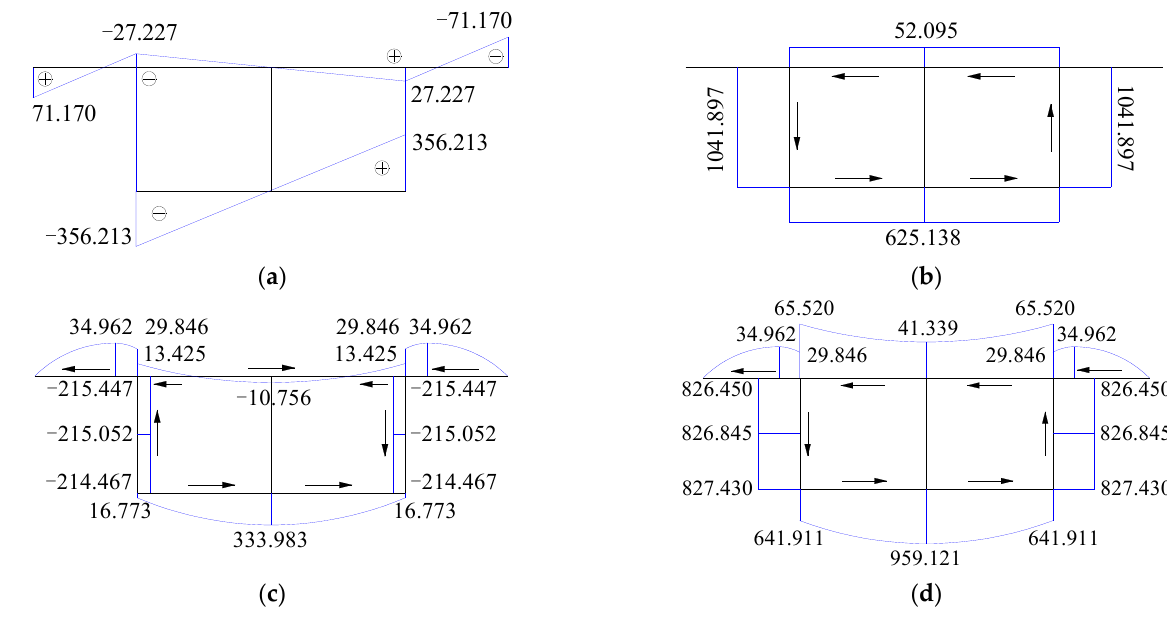
Figure 11. Distribution of torsional stress (unit: KPa): ( a ) σ ω ; ( b ) τ s ; ( c ) τ ω ; ( d ) τ